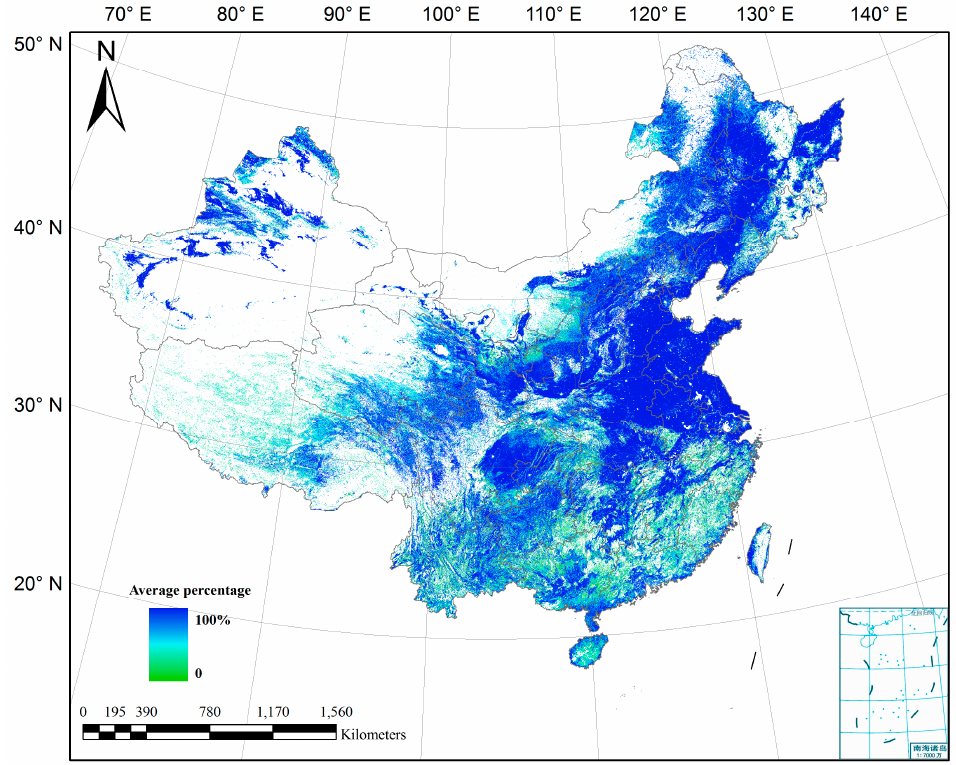
Figure 6. Average cropland percentage of the five input datasets.